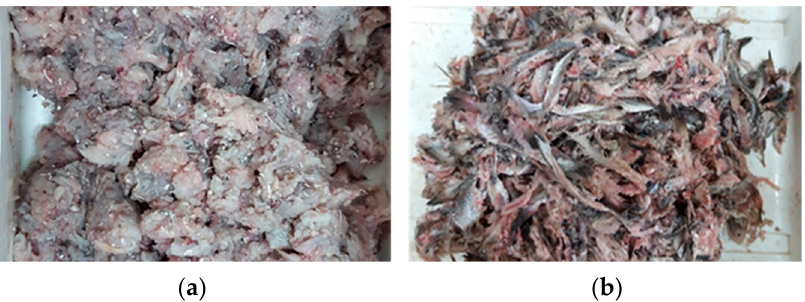
Figure 3. Fractions obtained after the mechanical separation of headed and gutted individuals of undersized hake: ( a ) muscle fraction and ( b ) skin and bone fraction.